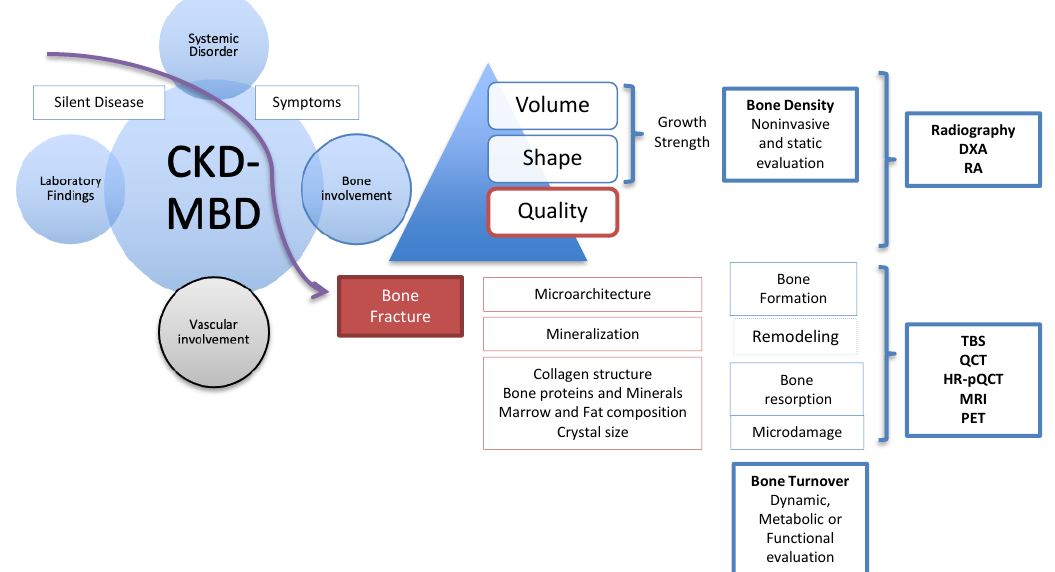
Figure 2. Progression of CKD-MBD from asymptomatic disease to bone fracture, bone parameters and associated imaging